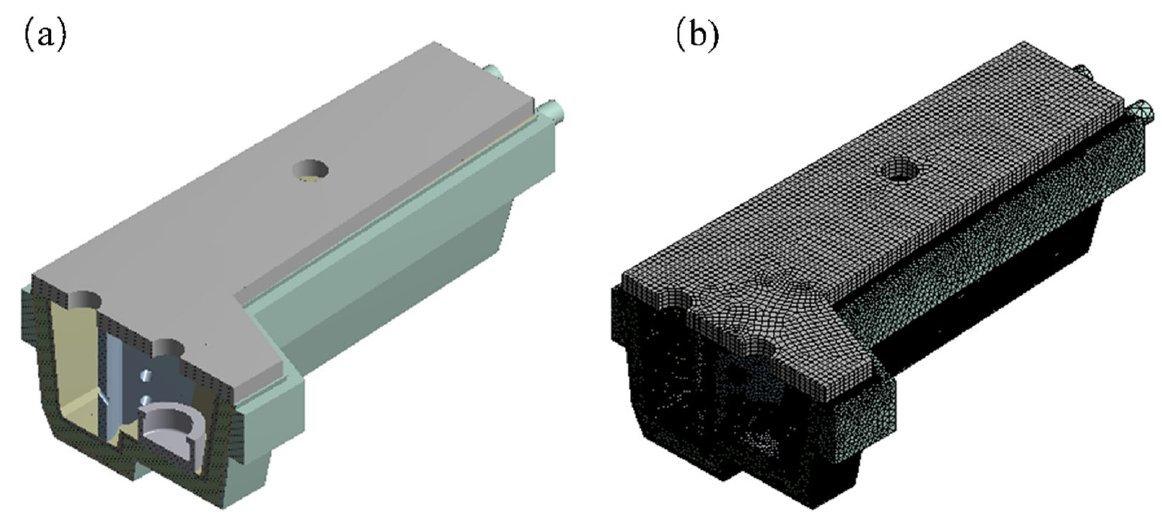
Figure 1. Geometry and mesh: ( a ) geometry; ( b ) grid of computational domain. Table 1. Physical properties of refractory linings.